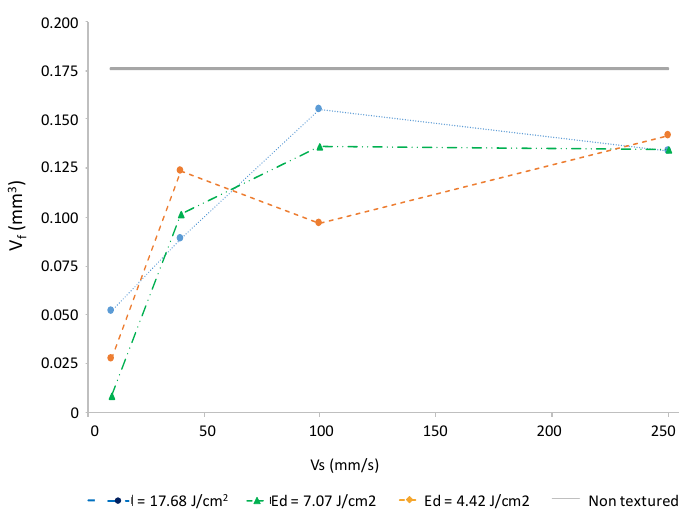
Figure 6. Wear volume evolution as a function of V s .